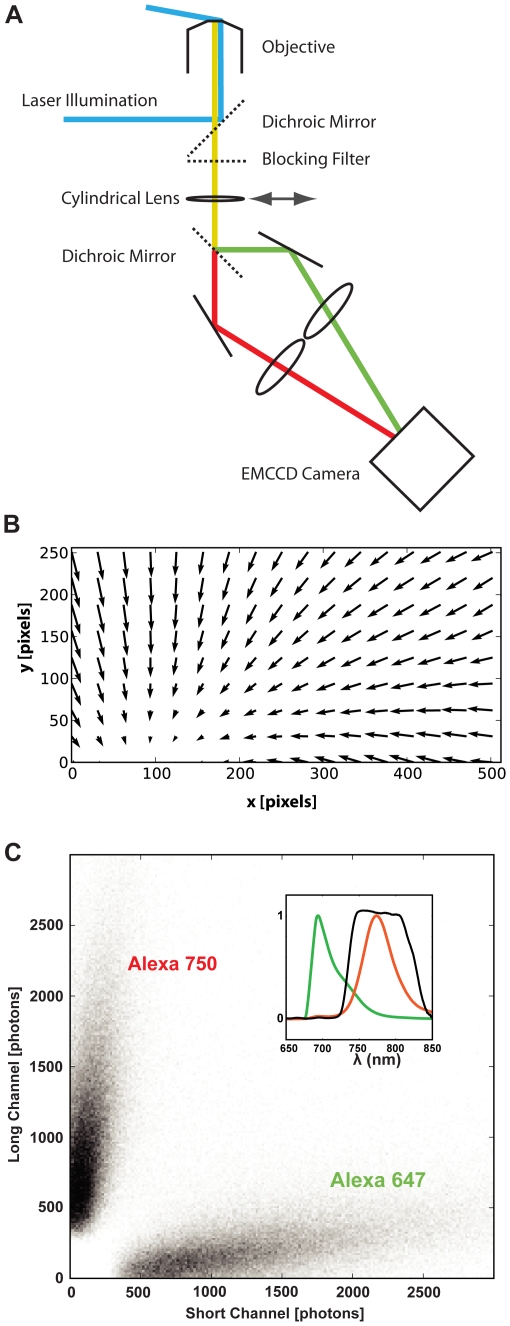
Schematic depicting optical setup for ratiometric localisation imaging.
A. A single laser at 671 nm is used to provide excitation and the collected light is split into two bands using a dichroic mirror. The bands are imaged side by side on an electron multiplying CCD (EMCCD). An optional cylindrical lens allows astigmatism based 3D localisation. B. A vector field that shows the distribution of lateral chromatic shifts between the channels measured with a bead calibration sample. This vector field was used for chromatic shift compensation during fitting of the single molecule events as detailed in the Methods. The longest arrows shown correspond to a shift magnitude of ∼90 nm. C. Single molecule events are observed as flashes with an intensity component in each channel. When these intensities are plotted against each other, discreet populations emerge corresponding to each fluorochrome in the sample. One such plot, obtained from a sample in which neurons had been transfected with GFP-alpha-sap97 and subsequently labeled with antibodies against GFP (Alexa 647 secondary) and synapsin (Alexa 750 secondary) is shown. Inset: Recorded emission spectra of Alexa 647 (green) and Alexa 750 (red), the black trace is the transmission curve of the dichroic mirror in the splitter device.